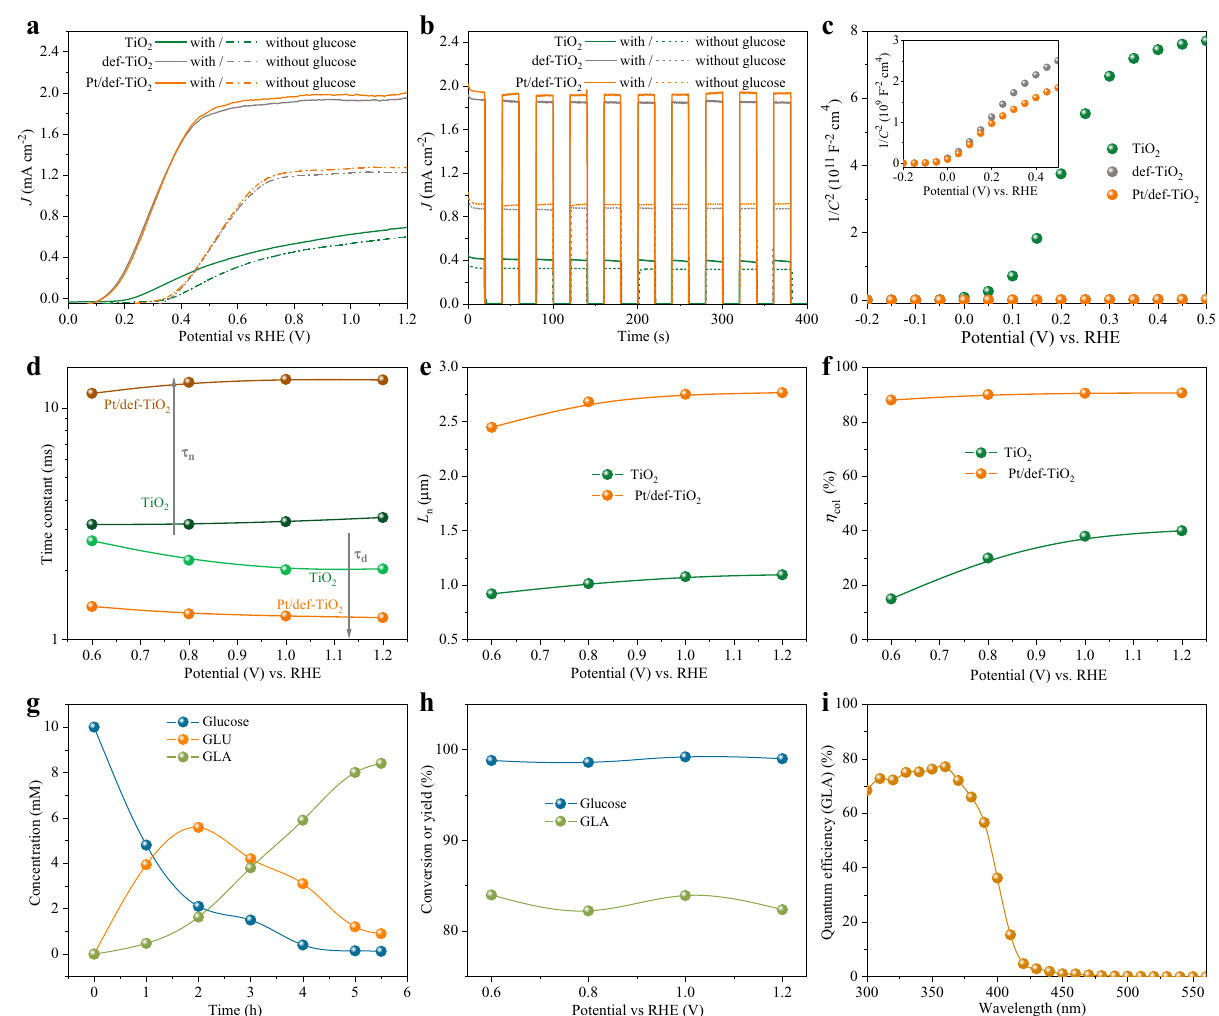
Fig. 4 | PEC performance for glucose oxidation. a LSV pro fi les of the TiO 2 , def- TiO 2, andPt/def-TiO 2 photoanodesforglucoseoxidationmeasuredin1MKOHwith andwithout10mMglucoseunderAM1.5G,100mWcm − 2 illumination. b Transient photocurrent responses of the samples at 0.6 V RHE 1M KOH with and without 10mM glucose. c Mott – Schottky plots of TiO 2 , def-TiO 2, and Pt/def-TiO 2 . Inset: Magni fi ed Mott-Schottky plots of def-TiO 2 and Pt/def-TiO 2 . d Time constants of